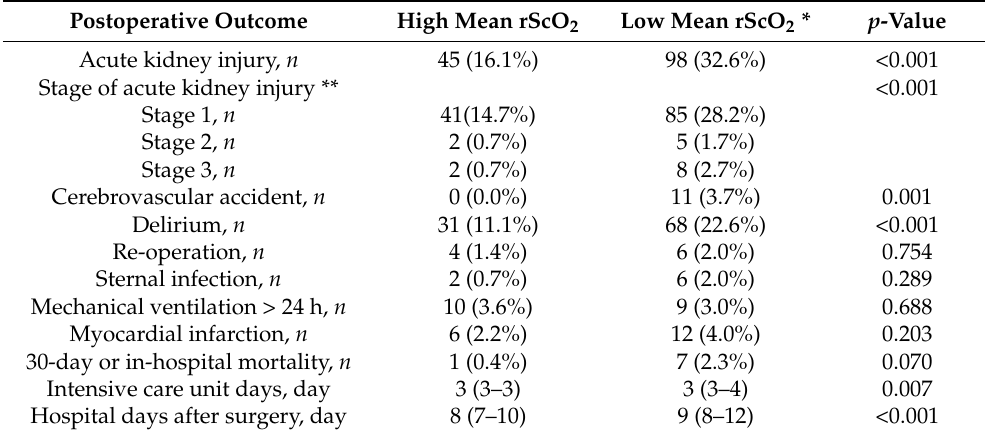
Table 4. Postoperative outcomes based on cutoff value for mean rScO 2